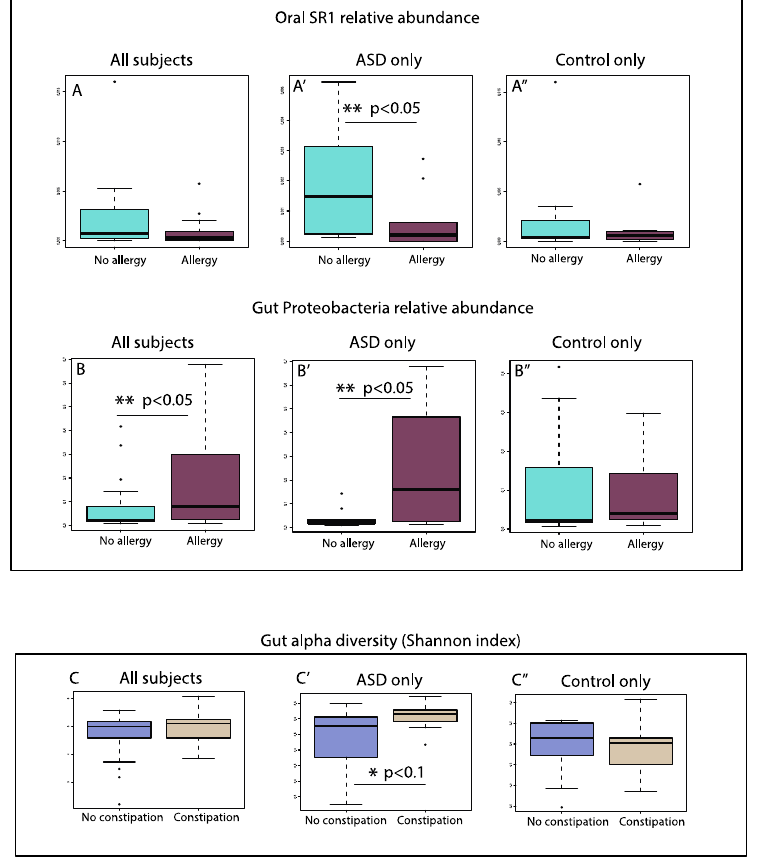
Figure 6. Box plot representation of the relative abundances of oral ( A – A” ) and gut ( B – B” ) bacterial phyla correlating with the allergy status of the subjects enrolled in this study. ( A ) Oral SR1 relative abundance in all subjects with no allergy and those with allergy; ( A’ ) Oral SR1 relative abundance in ASD subjects with no allergy and patients with allergy; ( A” ) Oral SR1 relative abundance in neurotypical subjects with no allergy and neurotypical subjects with allergy. ( B ) Gut Proteobacteria relative abundance in all subjects with no allergy and those with allergy; ( B’ ) Gut Proteobacteria relative abundance in ASD subjects with no allergy and patients with allergy; ( B” ) Gut Proteobacteria relative abundance in neurotypical subjects with no allergy and neurotypical subjects with allergy. Box plot representation of the gut alpha diversity (Shannon index) that correlated with the allergy status of the subjects enrolled in this study. ( C ) Gut alpha diversity in all subjects with no constipation and those with constipation; ( C’ ) Gut alpha diversity in ASD subjects with no constipation and patients with constipation; ( C” ) Gut alpha diversity in neurotypical subjects with no constipation and neurotypical subjects with constipation. Single asterisk indicates p < 0.1 with adjusted FDR > 0.2; double asterisk indicates p < 0.05 with adjusted FDR > 0.2, triple asterisk indicates p < 0.05 and adjusted FDR < 0.2, Kruskal–Wallis test.